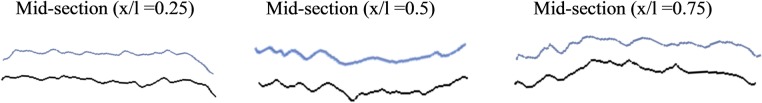
Comparison of wings at three section of the 3D model vs fabricated wing.